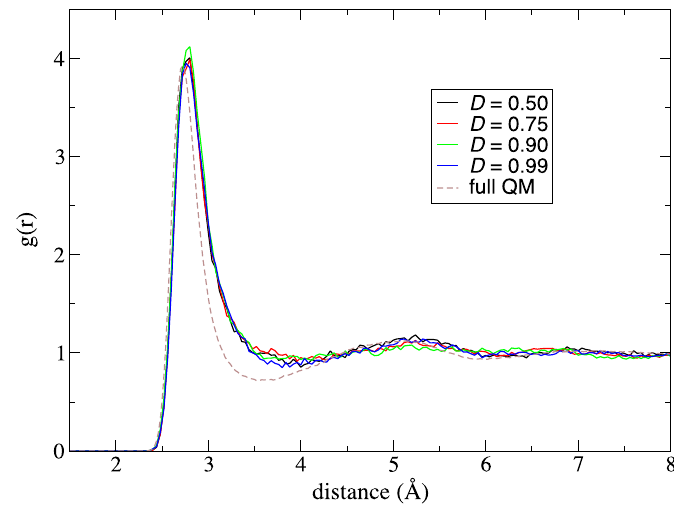
Figure 5. RDFs obtained from 100 ps SCMP simulations with 60 partitionings. Black, red, green and blue lines represent the results obtained by SCMP with degrees of order D = 0.50, 0.75, 0.90 and 0.99, respectively. Green line represents the result obtained by the previous SCMP code. Dashed line stands for the full DFTB3/3OB result.